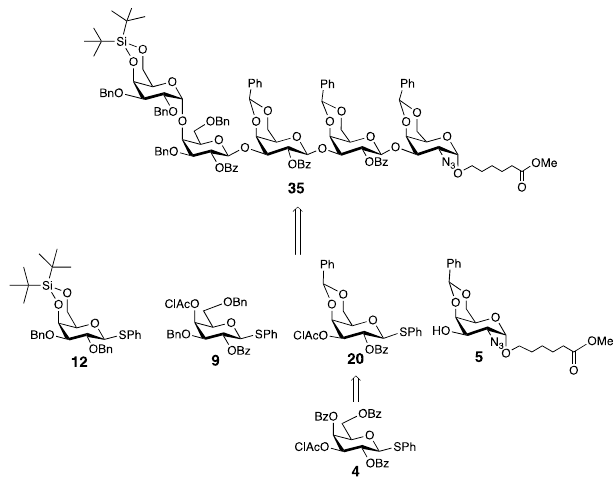
Figure 4. Revised synthetic strategy of pentasaccharide 35 .